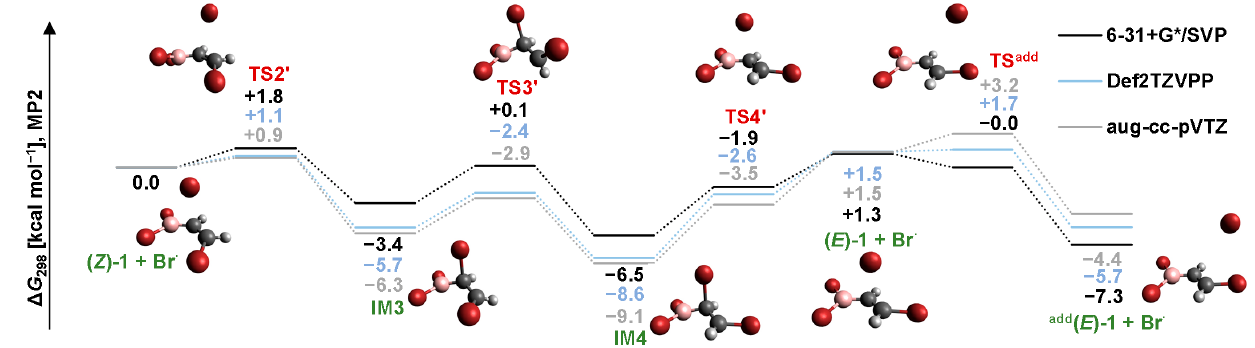
Figure 7. MP2 Gibbs free energy profile for bromine radical addition to “boron end” of ( Z )-1 followed by clockwise rotation around the C–C bond. Total electronic energies from Def2TZVPP and aug-cc-pVTZ basis sets were corrected by 6-31+G*/SVP ZPE contributions, thermal correction, and entropy terms at 298 K. For a key to atom color scheme, cf. caption of Figure 1. Table 2. MP2 and dispersion-corrected B3LYP ZPE values for bromine radical attack to the “boron end”. ZPE Corrections/ kcal mol −